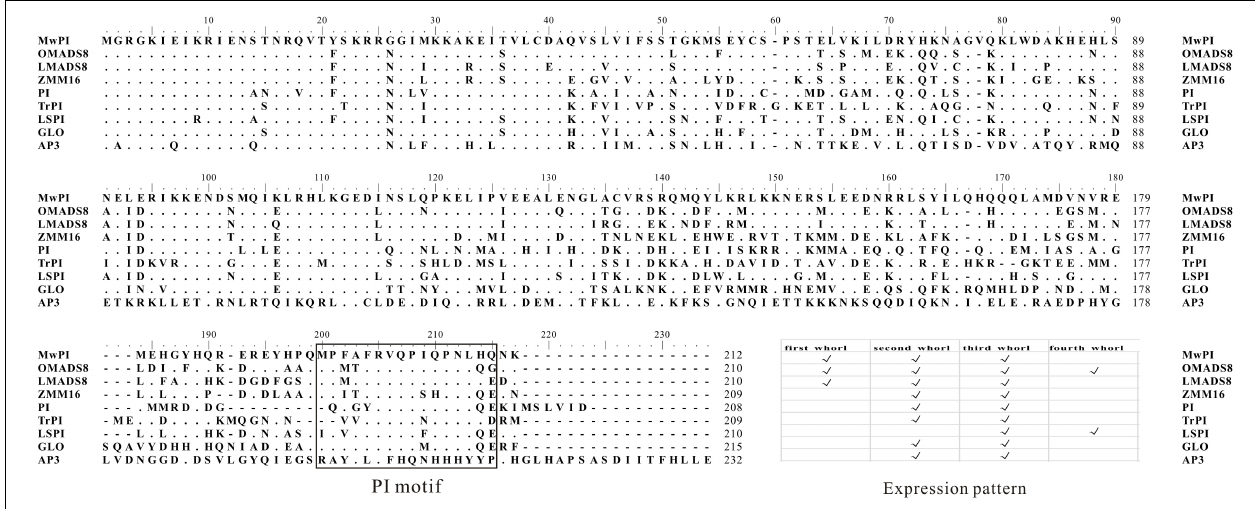
FIGURE 1 | Comparison of deduced amino acid sequences encoded by MAwuPI and related members of the PI/GLO lineage. Dots indicate gaps inserted for alignment optimization. Sequence comparison of MAwuPI and the PI/GLO-related MADS domain proteins. The PI motif in the C-terminal region is boxed. The motif is highly conserved for PI/GLO lineage proteins with a DEF/AP3 protein (AtAP3) as a contrast. Meanwhile, a schematic expression of the selected genes in the four whorls of the flowers is also combined.